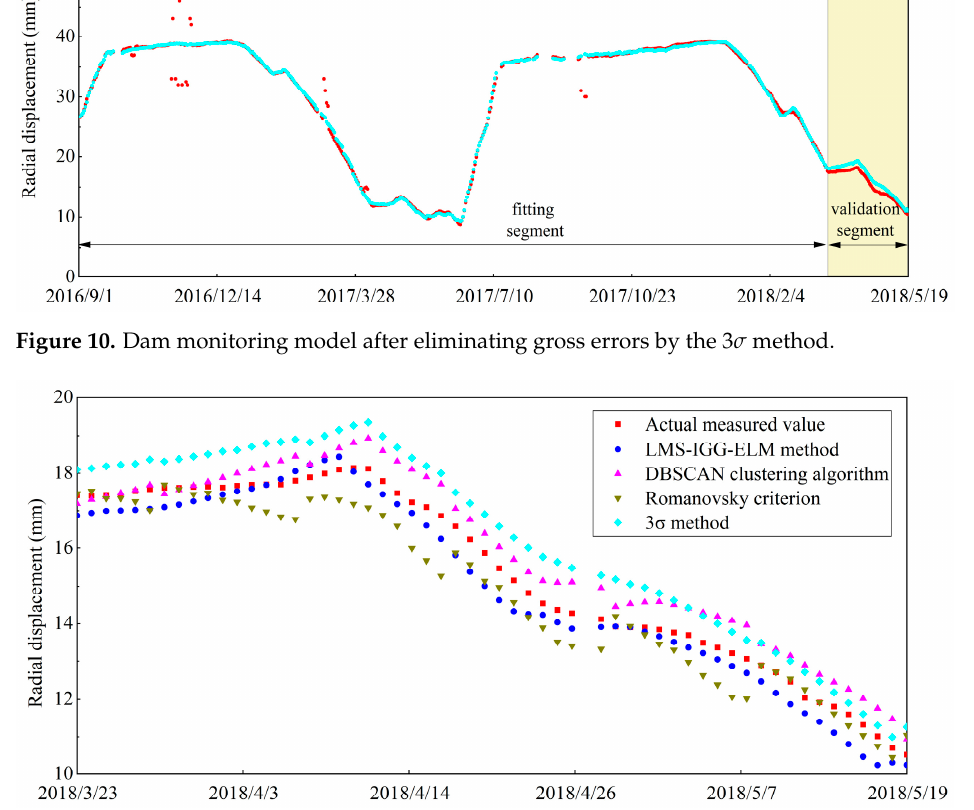
Figure 11. Effect comparison chart of the dam validation segment after eliminating gross errors by the four methods.